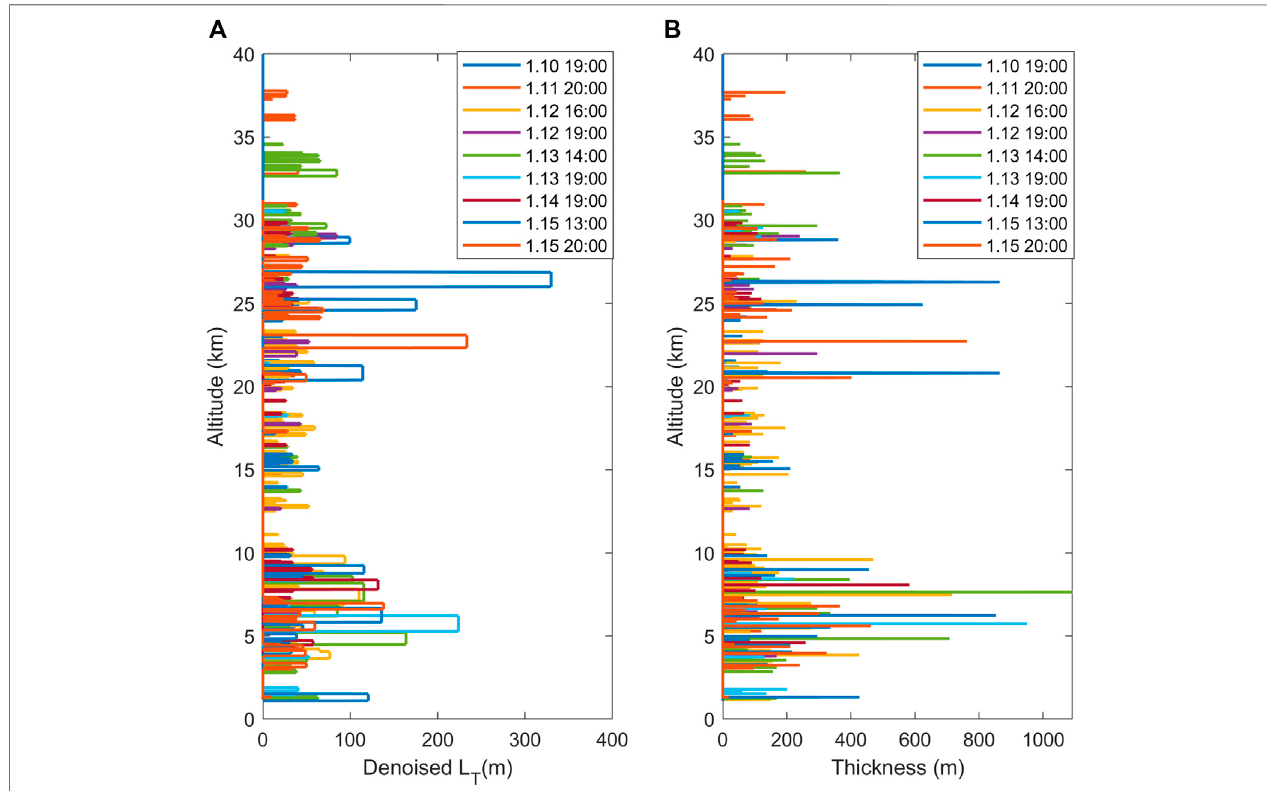
FIGURE 2 | Vertical pro fi les of Thorpe scale and Turbulence thickness of 9 sets of radiosonde data calculated by Thorpe method. (A,B) show Thorpe scale and turbulence thickness respectively.